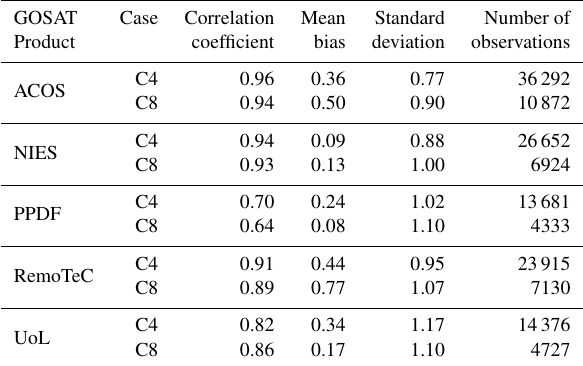
Table 9. Comparison of collocation methods C4 and C8 using ACOS, NIES, PPDF, RemoTeC and UoL GOSAT products near the Darwin site.